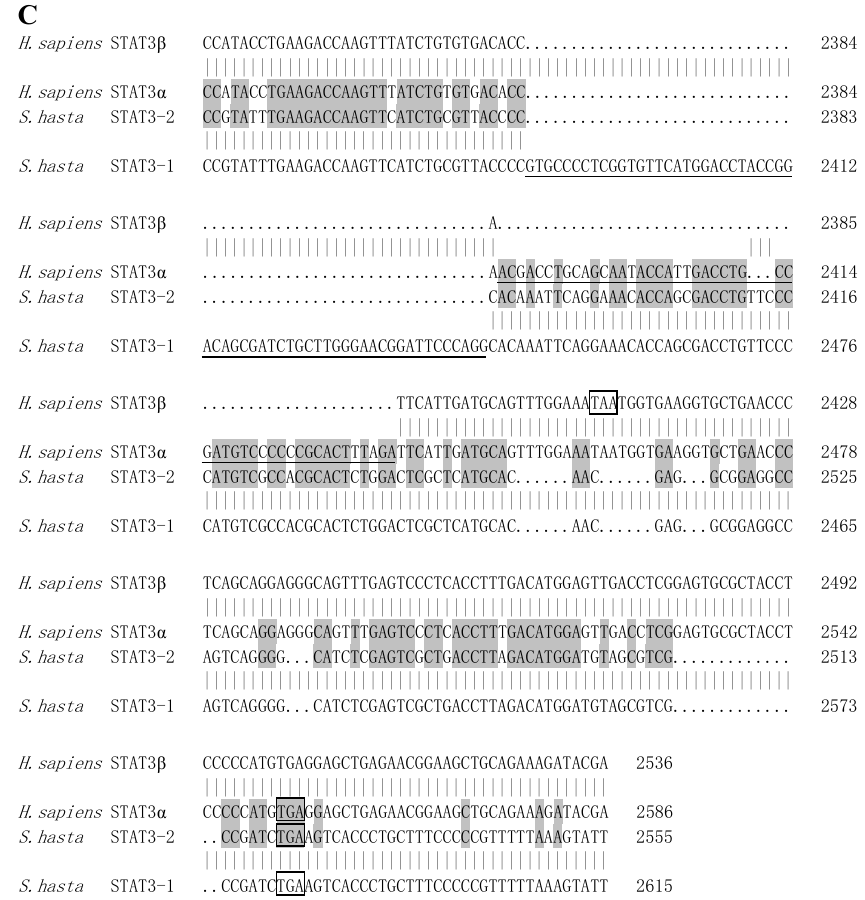
Figure 2. Multiple sequence alignment of STATs. The accession numbers from Ensemble databases are given in Supplementary Table S1. Numbers on the right indicate the amino acid positions. Identical (*), high similar (:) and low similar (.) residues were indicated below the alignment. Hyphens represent spaces inserted to maximize similarity. ( A ) Alignment of the deduced amino acid sequences of STATs from S. hasta . Spliced sites are indicated by upward arrowheads. Conserved phosphorylation sites in all STAT members are shaded by a dark background. Different amino acids generated by alternative splicing are indicated by an underline; ( B ) Alignment of STAT3 amino acid sequences from S. hasta , D. rerio , H. sapiens and R. norvegicus . Curved arrowheads represent the boundaries of different domains. Upward arrowheads represent spliced sites. Different amino acids generated by alternative splicing are indicated by an underline. A solid triangle represents a single phosphotyrosine that is present in all activated STATs, and an open triangle represents a single phosphoserine that is present in several STATs [1]. A single lysine residue that regulates STAT3 dimerization by reversible acetylation is denoted by an oval frame. Boxes and stars represent the LPMSP motif [18]. Nuclear export signals (NES) are indicated by a box and an upward arrowhead [19]. Nuclear localization signals (NLS) are indicated by a box and a downward arrowhead. A dotted box represents the region that plays a role in nuclear translocation induced by growth hormone in STAT5B, but mutation of it has no effect in STAT3 [20]. The amino acid divergence between fish and mammals is shaded by a dark background; ( C ) Alignment of STAT3 nucleotides sequences from S. hasta and H. sapiens . The conserved nucleotides of STAT3 in the same species are indicated by a vertical line. The conserved nucleotides between H. sapiens STAT3 α and H. hasta STAT3-2 are shaded by a dark background. The positions of the stop codons are indicated by a box. Different cDNA sequences generated by alternative splicing are indicated by an underline.